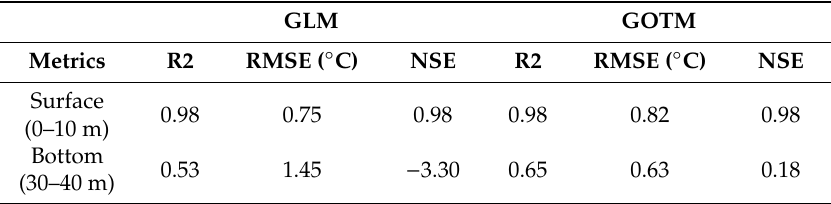
Figure 4. Results of the GLM calibration and validation process. Top panels represent the surface (0–10 m) layer and the bottom panels the bottom layer (30–40 m) of the water column. Panels ( A ) and ( C ) provide a time-series comparison; A correlation between observed and simulated water temperature is provided in panels ( B ) and ( D ). Table 4. Results of GLM and GOTM calibration and